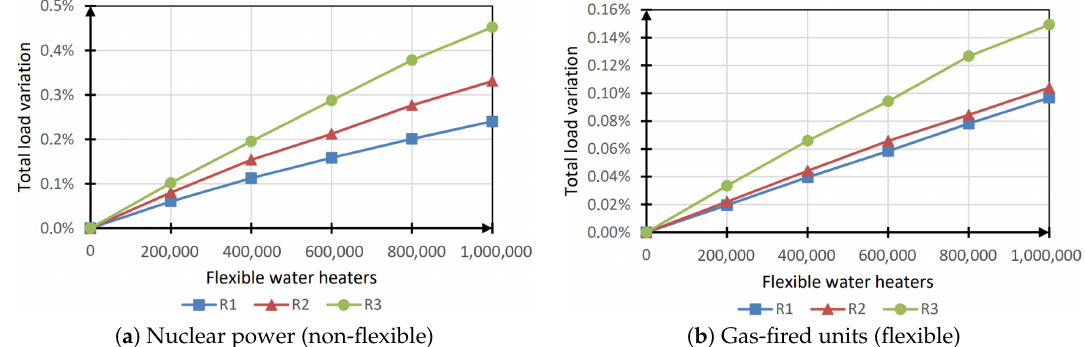
Figure 6. Total load variation (water heaters).